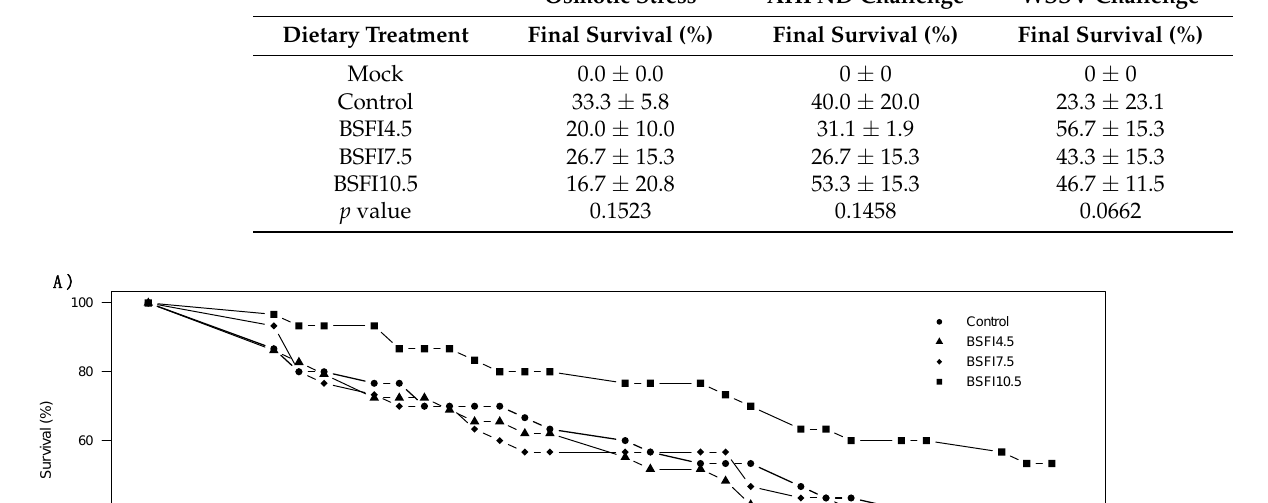
Table 3. Survival of Litopenaeus vannamei exposed to osmotic stress, acute hepatopancreatic necrosis disease (AHPND), or white spot syndrome virus (WSSV). Shrimp were fed four experimental diets over 28 days (control, and experimental diets with 4.5%, 7.5%, and 10.5% Black soldier fly derived novel feed ingredient, respectively BSFI4.5, BSFI7.5, and BSFI10.5), survival is presented as mean ± standard deviation.